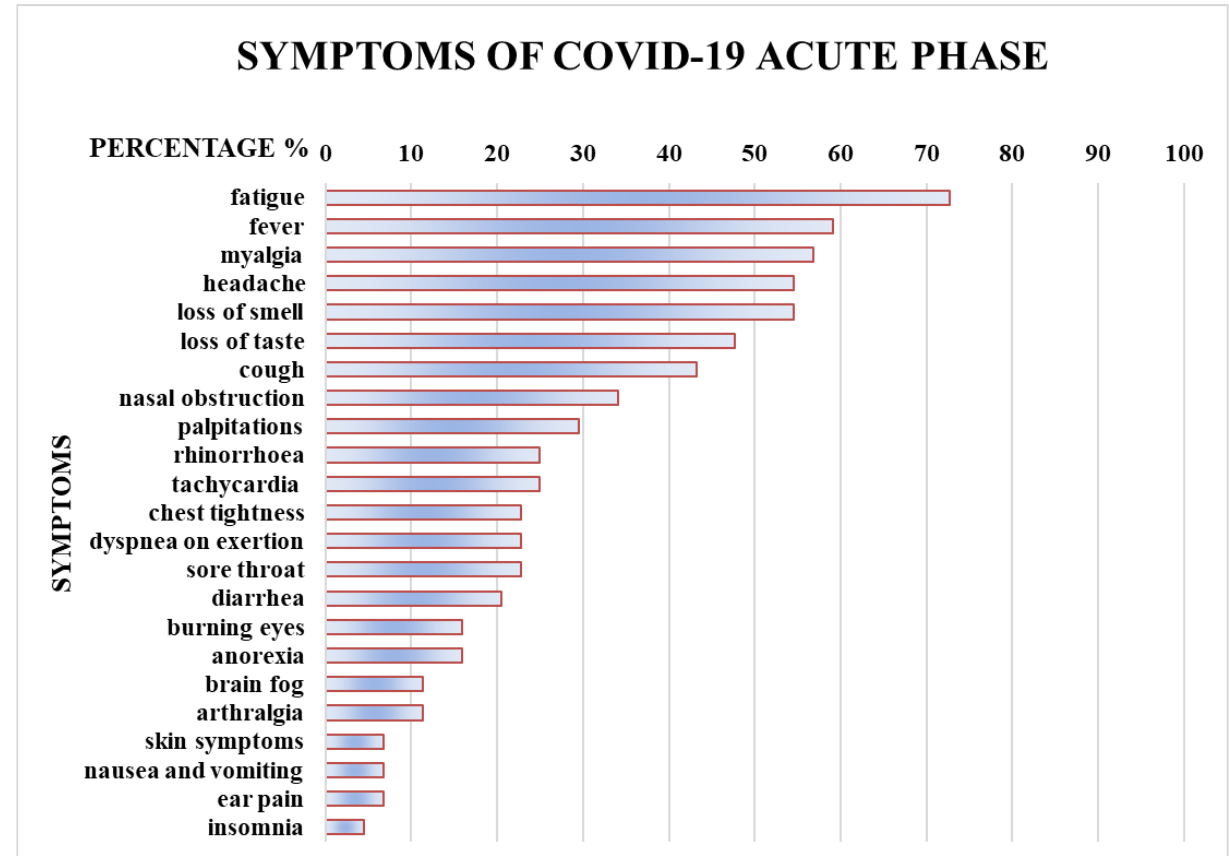
Figure 1. COVID-19 acute phase most commonly reported symptoms by HCWs at their health surveillance visits. Values are given as percentages (%). Table 2. Frequency domain analysis for autonomic balance, and time domain analysis for HRV parameters (mean ± standard deviation and median IQR 25–75), among recovered COVID-19 and control group HCWs.